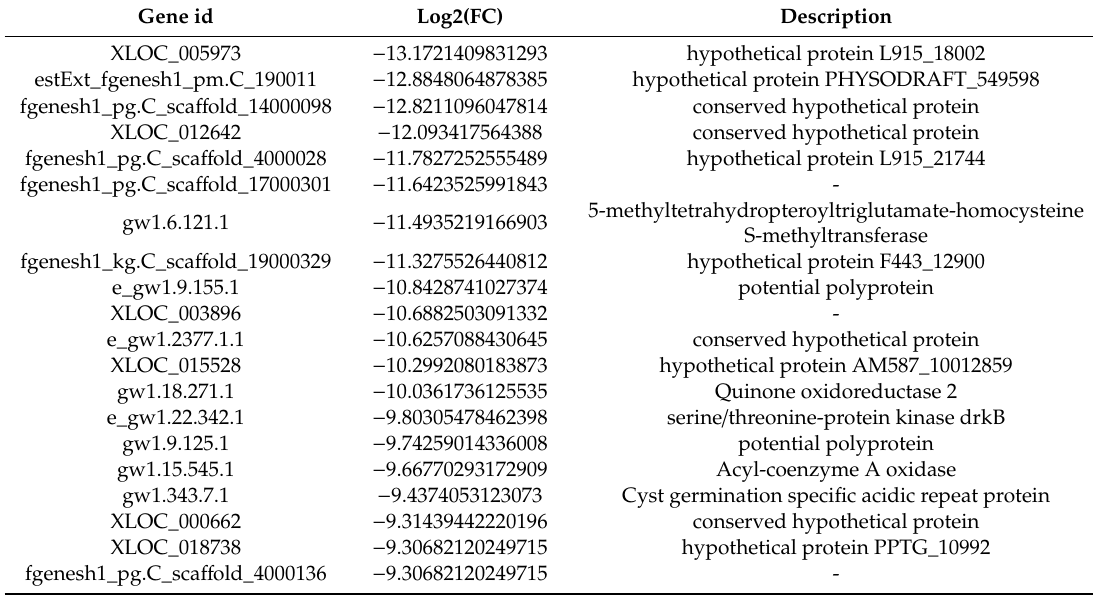
Table 5. Top 20 downregulated genes of P. capsici